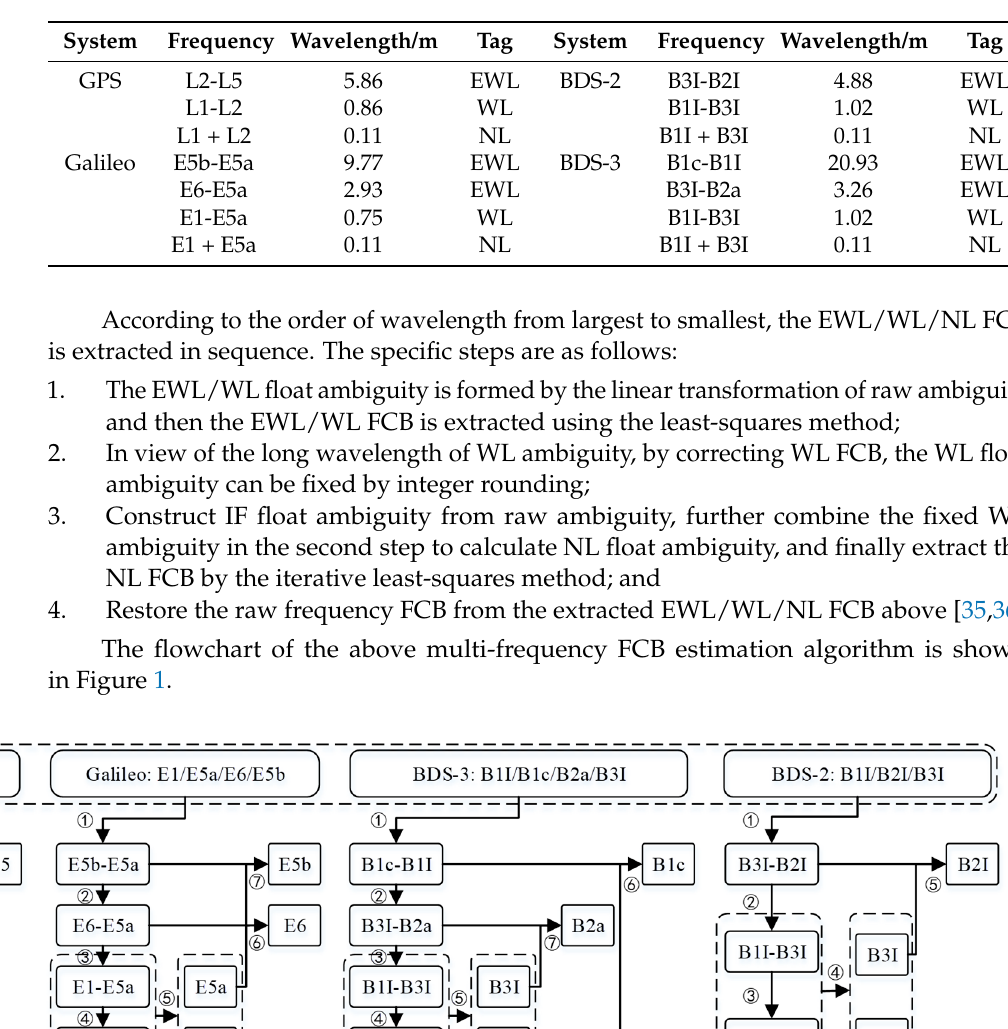
Table 1. EWL/WL/NL combinations of GPS, Galileo, BDS-2, and BDS-3 for FCB estimation.